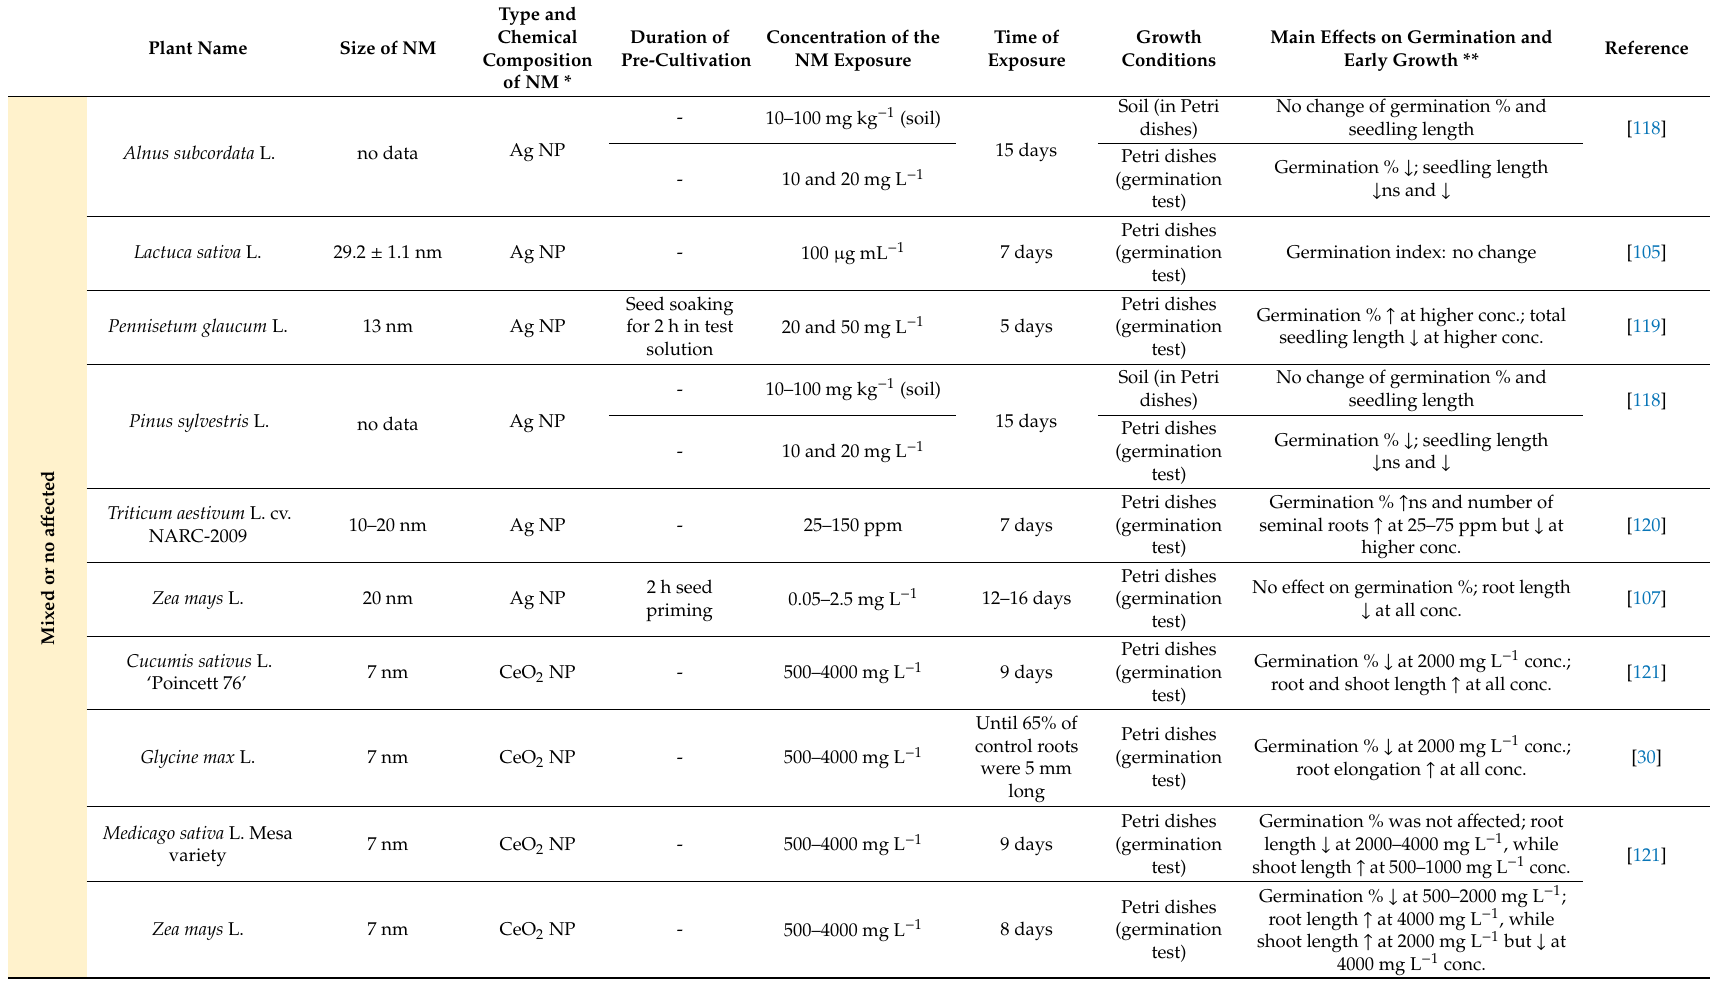
Table 2. Mixed or no e ff ect of metal and metal oxide NPs on seed germination and seedling